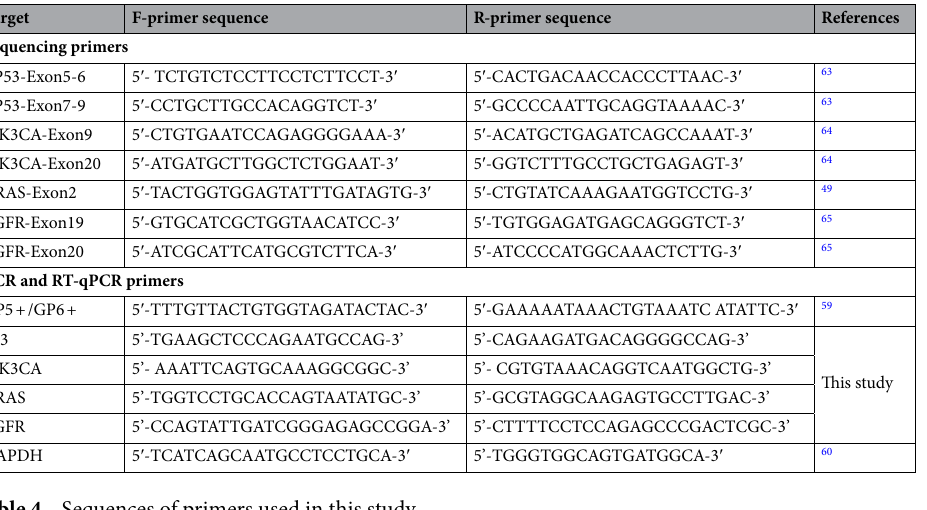
Table 4. Sequences of primers used in this